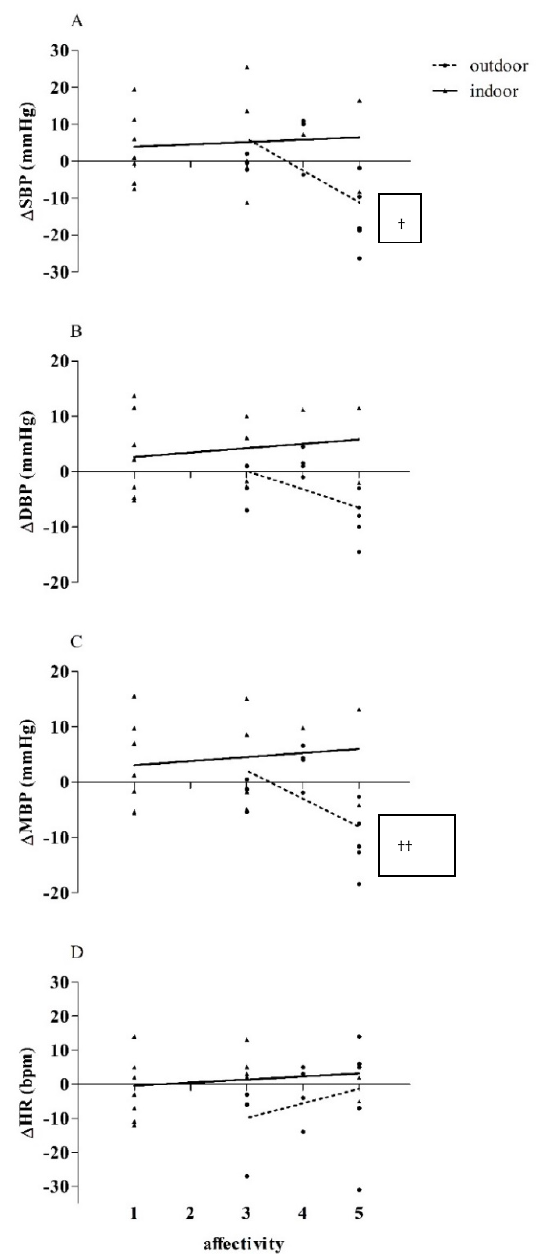
Figure 2. Correlation between the effect of training on BP, HR, and affective response after nine weeks of combined indoor and outdoor training. ∆ = difference between the post 9 weeks value and the baseline value. † —indicates values of r = − 0.60 and p = 0.03 for SBP of the OCT group. †† —indicates values of r = − 0.62 and p = 0.02 for MBP of the OCT group.